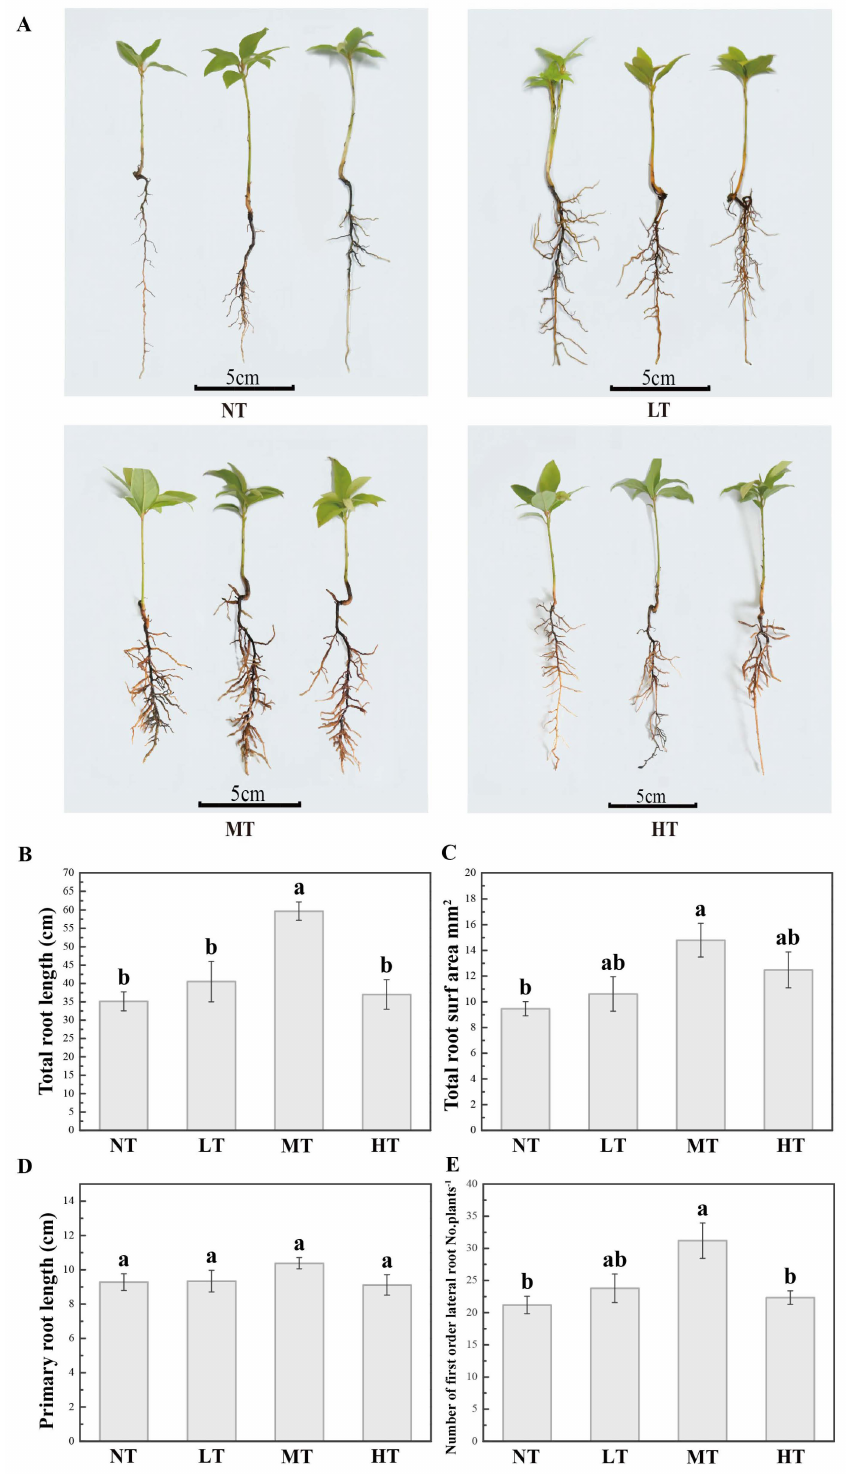
Figure 1. The medium concentration of paclobutrazol (PBZ) significantly promoted root morpho- logical traits in P. bournei . ( A ) Three-month-old seedlings grown under control (NT), 0.6 mg/L (LT), 6 mg/L (MT), and 60 mg/L (HT) treatments of PBZ. ( B – E ) Root traits, including total root length (TRL), total root surf area (SA), primary root length (PRL), and lateral root number (NLR), respectively, under different treatments of paclobutrazol. Different lowercase letters indicate significant differences under four PBZ treatments (ANOVA, p ≤